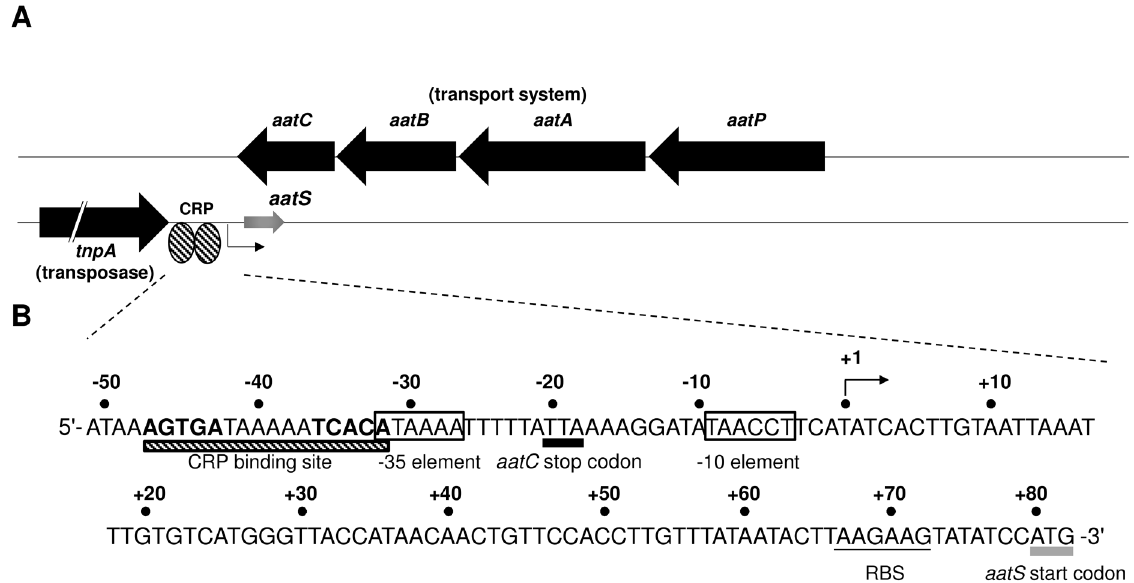
Fig 1. The aatPABC operon of ETEC H10407. Schematic of the aatPABC operon and adjacent tnpA gene. The two DNA strands are shown as black lines. Known genes are shown as black arrows and the predicted aatS gene as a grey arrow. Gene names are shown in italic and gene function in parenthesis. The position of a putative CRP binding site is indicated by striped ovals. A. Sequence if the tnpA - aatC intergenic region. The CRP site is highlighted as a striped rectangle with the two half sites highlighted bold. The start codon of the aatS open reading frame is highlighted with a grey rectangle. The transcription start site, as determined by mRNA primer extension is denoted “ +1 ” and indicated by a bent arrow. Distances upstream (-) and downstream (+) of this start site are numbered. The -35 and -10 hexamers are boxed, and the ribosome binding site (RBS) is underlined.